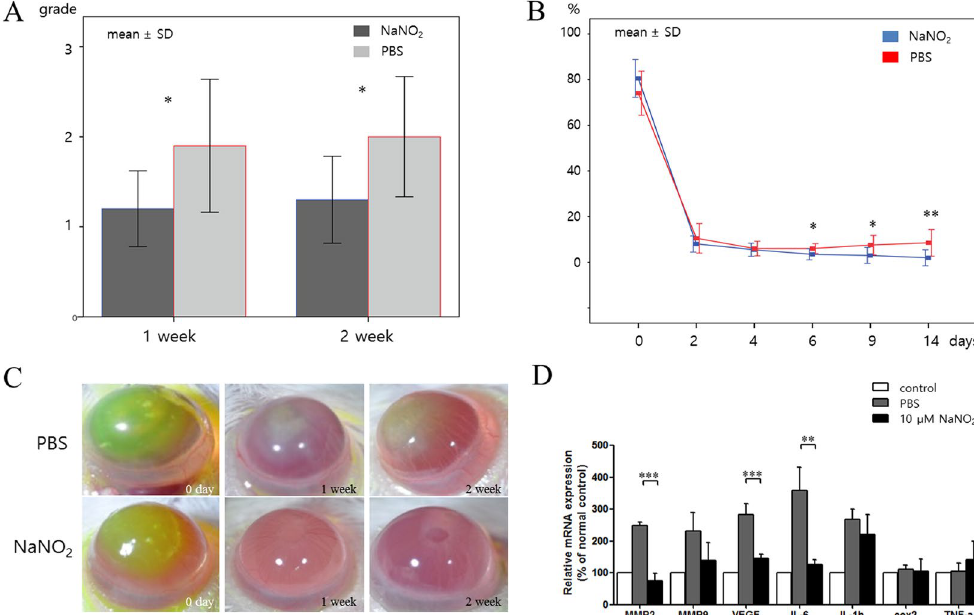
Figure 7. In vivo effect of NO on corneal wound healing following alkali burn. ( A ) Corneal opacity of NO- treated corneas was significantly alleviated than those in the PBS control group, both at 1 and 2 weeks. Higher grade means higher opacity. ( B ) Corneal epithelial defect size (%) was traced. Corneal epithelial healing was faster in NO-treated corneas and the defect size was smaller compared to those in the PBS control group, from days 6 to 14. ( C ) Representative photographs of the alkali-burned murine cornea at 0, 7, and 14 days after injury. The green area represents the corneal epithelial defect stained with fluorescein. Corneal opacity is prominent in PBS-treated cornea compared to the NaNO 2 -treated cornea. Pupil is clearly visible in NaNO 2 -treated cornea at 2weeks with no epithelial defect. ( D ) Inflammatory cytokine expression from cornea measured at 2 weeks after injury revealed significantly decreased mRNA expression of MMP2, VEGF, and IL-6 in NaNO 2 -treated corneas. ** p < 0.01, *** p <